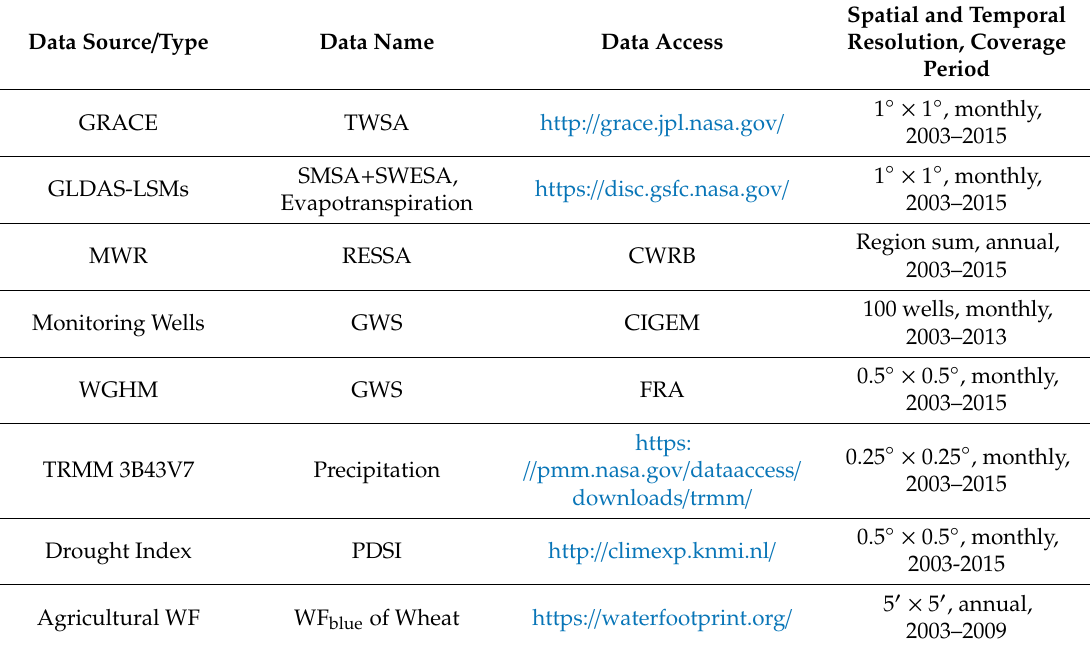
Table 1. Summary of the data used in this